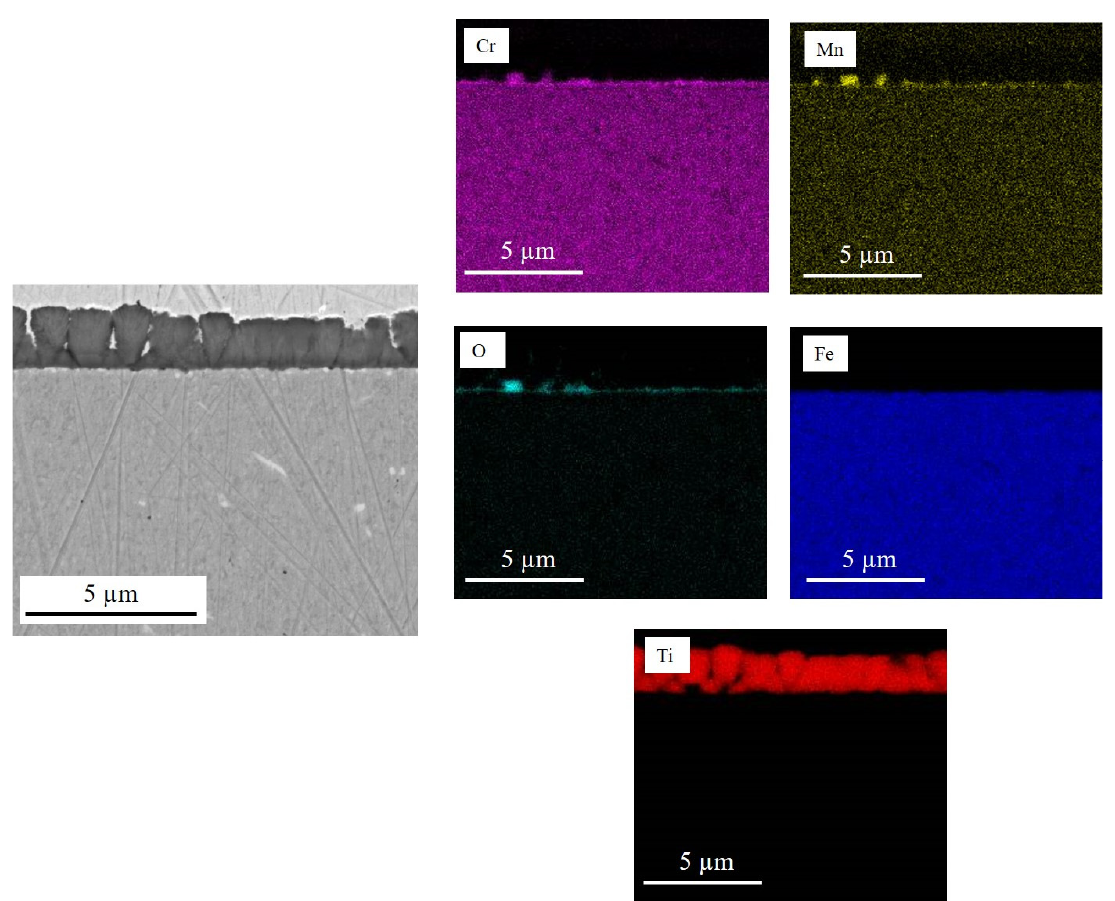
Figure 10. Backscattered electron image and EDX elementary maps of the cross section of the Ti coating deposited on the pre-oxidized steel.